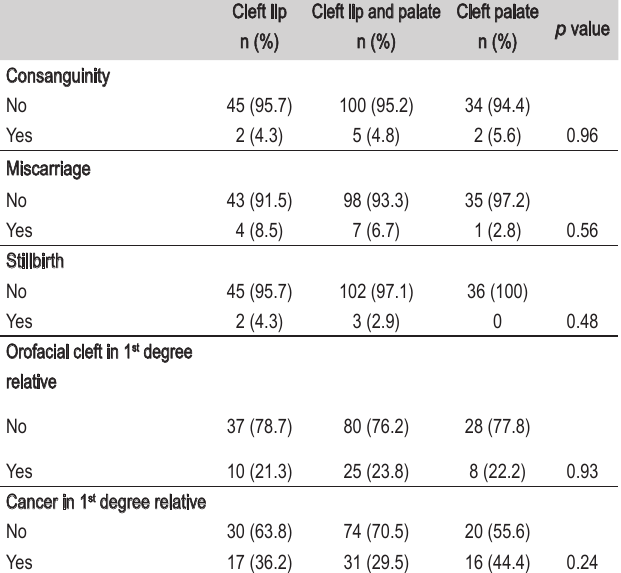
Table 4 - Characteristics of parents and relatives of the patients with nonsyndromic cleft lip and/or